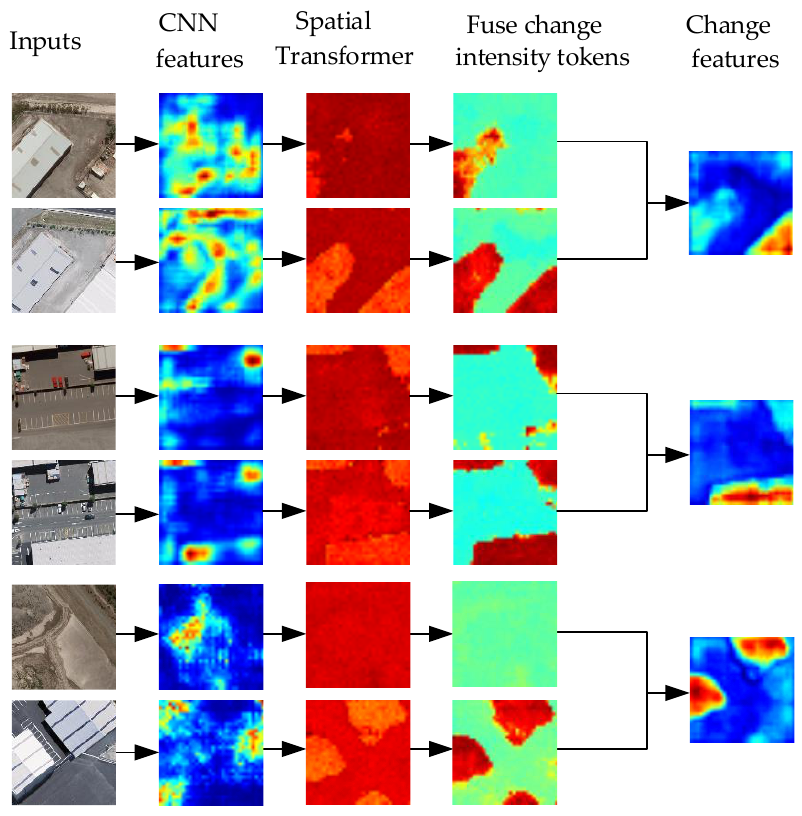
Figure 11 . Visualization of pre- and post-image features by change intensity tokens. Figure 11. Visualization of pre- and post-image features by change intensity